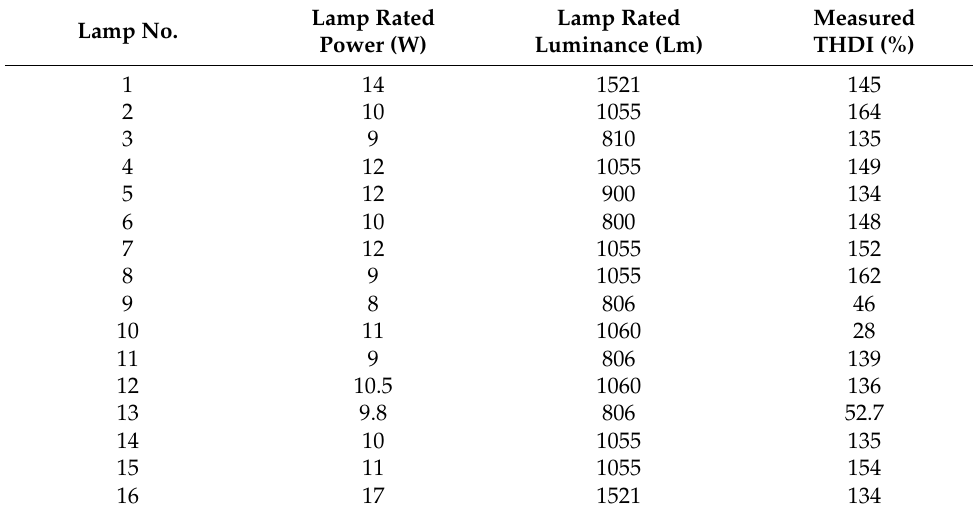
Table 1. Parameters of lamps used for testing. Lamp